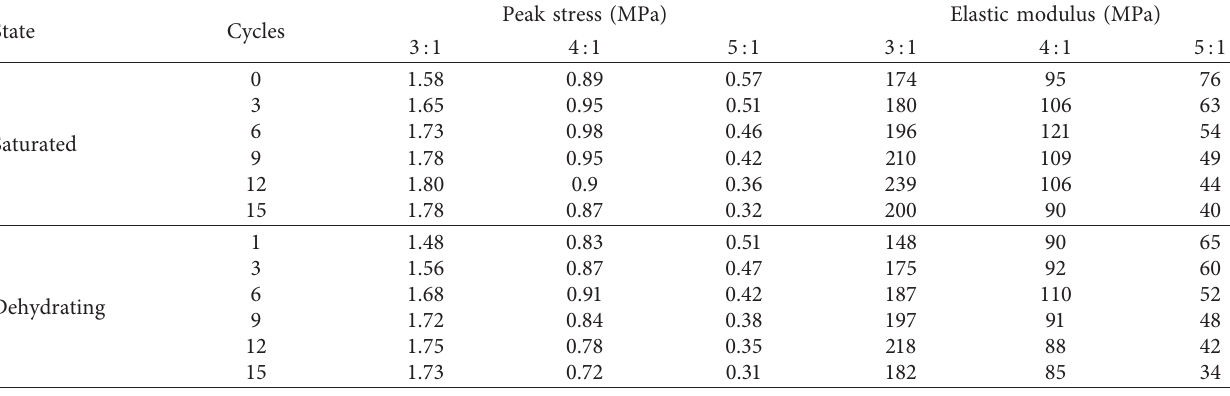
Table 3: Average peak stress and elastic modulus of specimens under different dry-wet cycles.